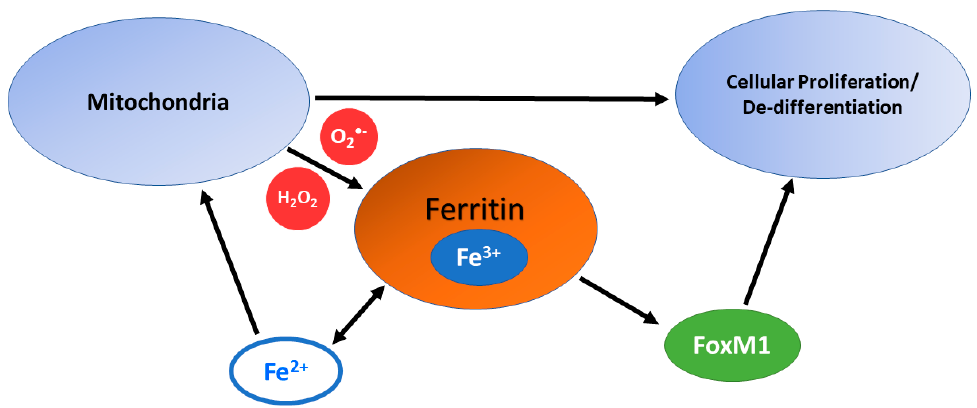
Figure 3. Potential consequences from overexpression of ferritin in cancer cells. Ferritin holds iron that can be labilized by increased levels of ROS generated by mitochondria. This “liberated” iron could be taken up by mitochondria to support proliferation. At the same time, ferritin could act in a signaling capacity by increasing expression of the promitotic, oncogenic transcription factor, FoxM1.